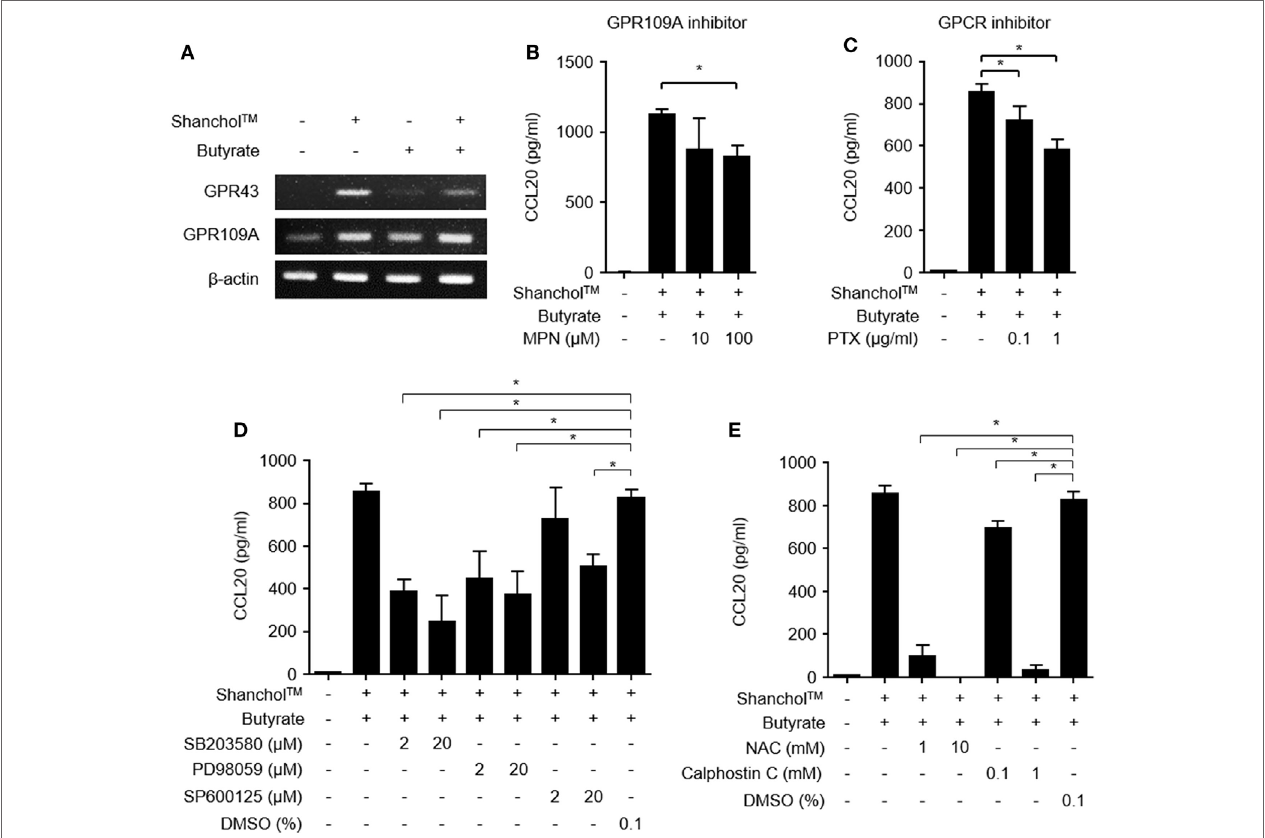
FigUre 3 | Activation of GPR109A and MAPK is involved in CCL20 secretion from Caco-2 cells. (a) Caco-2 cells were stimulated with Shanchol ™ (10 9 CFU/ml) in the presence or absence of butyrate (10 mM) for 3 h. Total RNA was extracted, after which the mRNA expression levels of GPR43 and GPR109A were determined using RT-PCR. (B–e) Caco-2 cells were pretreated with the indicated concentrations of mepenzolate bromide (MPN) (B) , pertussis toxin (PTX) (c) , SB203580, PD98059, SP600125, or DMSO (vehicle control) (D) , and NAC, Calphostin C, or DMSO (vehicle control) (e) for 1 h. Then, cells were co-stimulated with Shanchol ™ (10 9 CFU/ml) and butyrate (10 mM) for an additional 24 h, the culture supernatants were collected, and the concentrations of secreted CCL20 were measured by ELISA. One of three representative results is shown. All results are expressed as mean ± SD of triplicate samples. The asterisk (*) indicates a statistically significant difference ( P < 0.05) compared with the appropriate